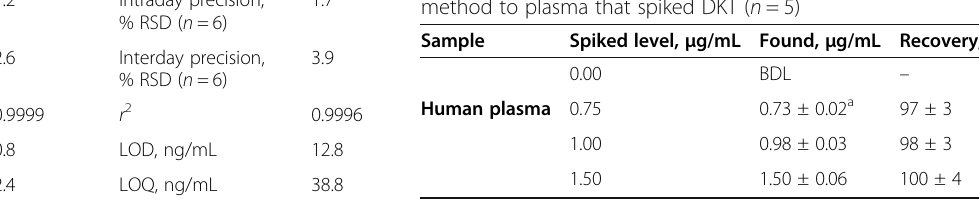
Table 2 Application of the coacervative